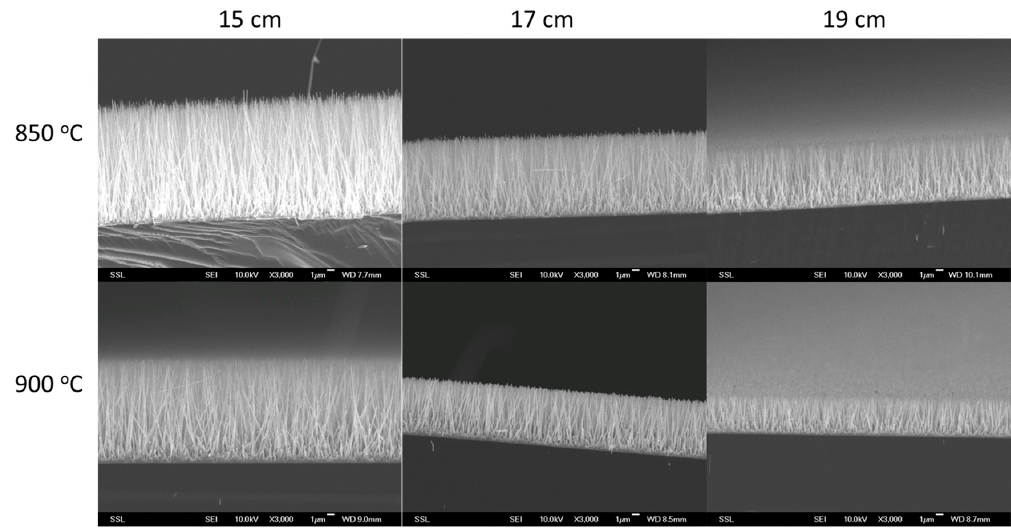
Figure 2. SEM images of vertically aligned zinc oxide (ZnO) nano-rods on silicon substrates using chemical vapour deposition (CVD), comparing the effect of temperature (850 vs. 900 °C) at distances of 15, 17, and 19 cm from the furnace source and powdered mix.